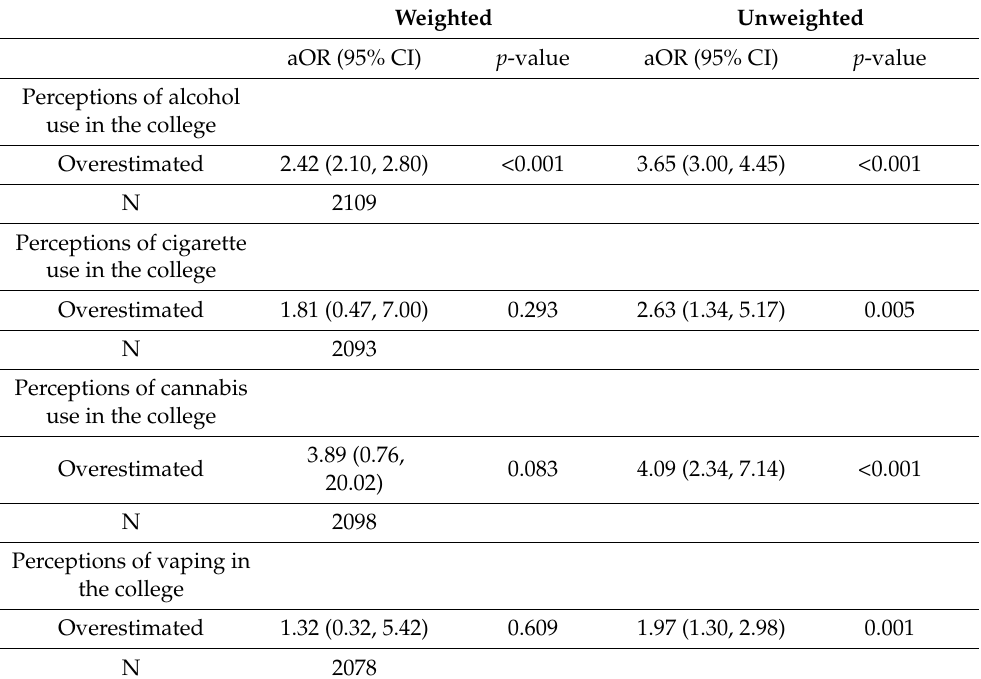
Table 1. Multivariable logistic regression models showing the association between overestima- tion of substance use at one’s school and substance use, Healthy Minds Study, September